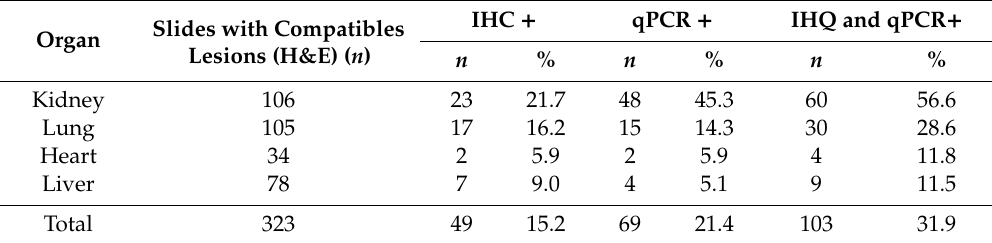
Table 4. Detection of pathogenic Leptospira spp. by IHC, qPCR, and IHC plus qPCR together in di ff erent organs from rodents trapped in dairy farms in the Los R í os Region, Chile.